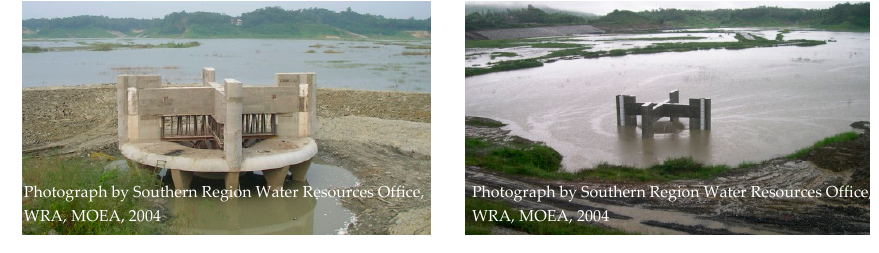
Figure 2. Shaft spillway pipe.